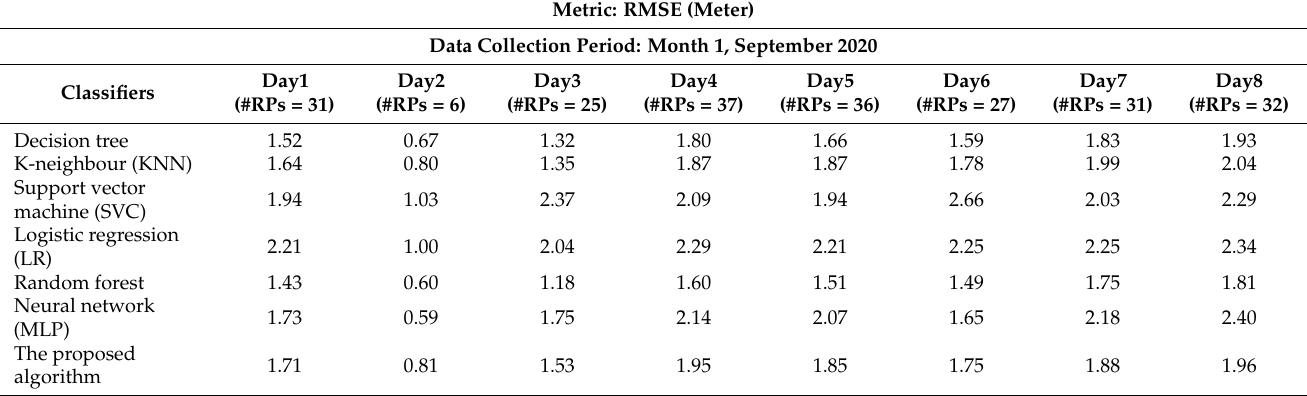
Table 6. Models vehicle’s indoor parking lots of CSI-based fingerprints of various datasets with different temporal